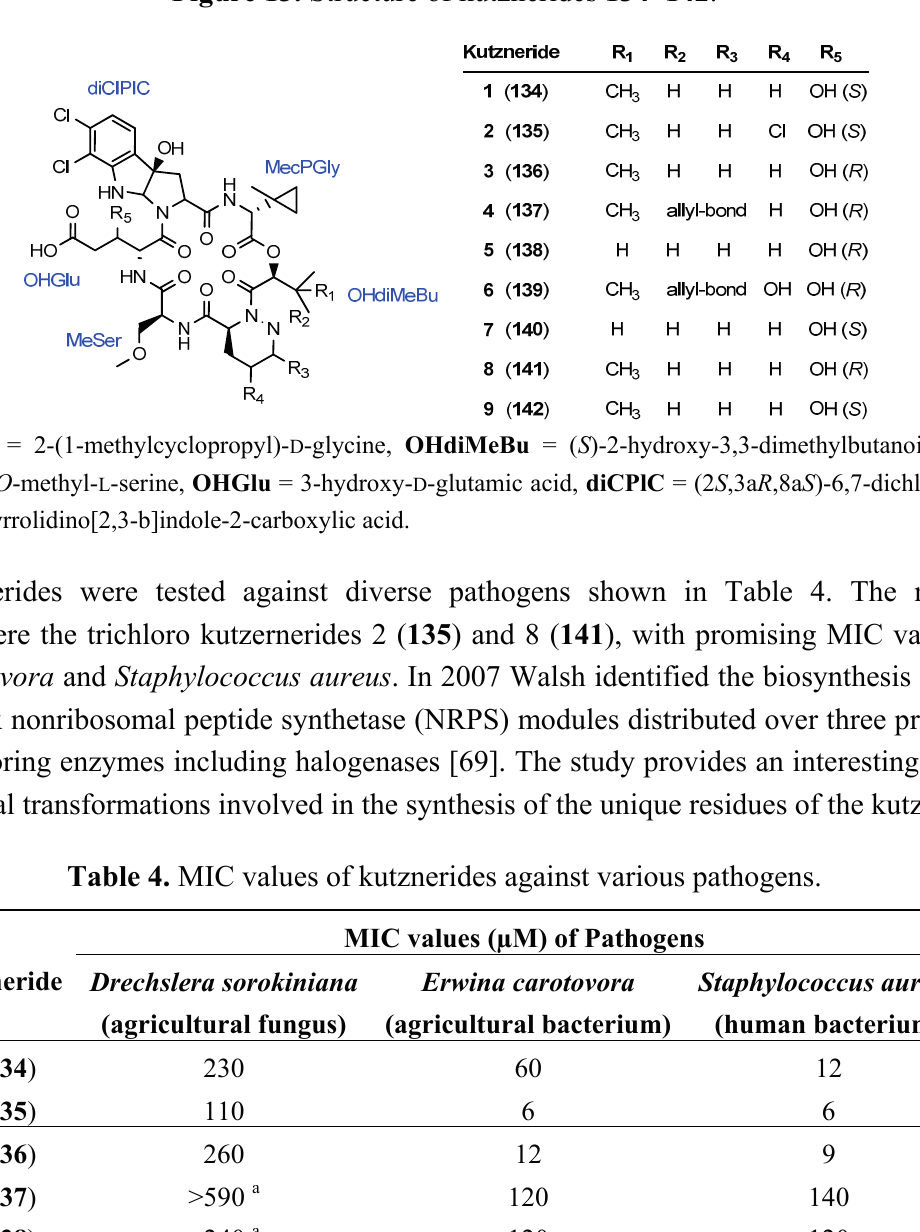
Figure 13. Structure of kutznerides 134 – 142 .